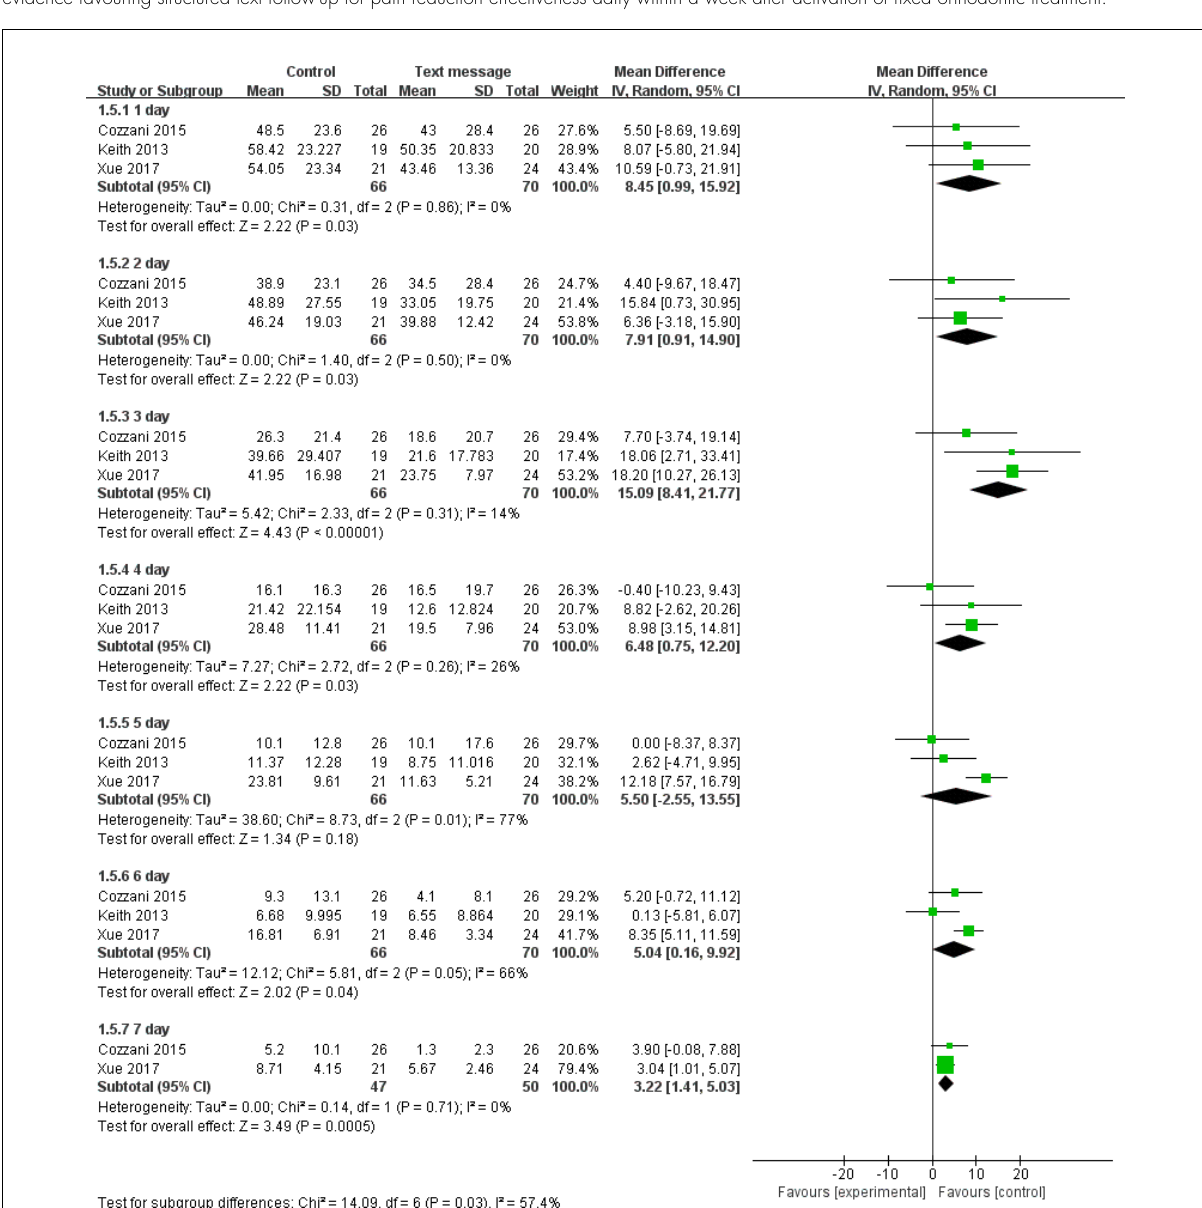
Supplementary Figure 5. Structured text follow-up and control for meta-analysis results, reported in mean difference (95% confidence interval), show evidence favouring structured text follow-up for pain reduction effectiveness daily within a week after activation of fixed orthodontic